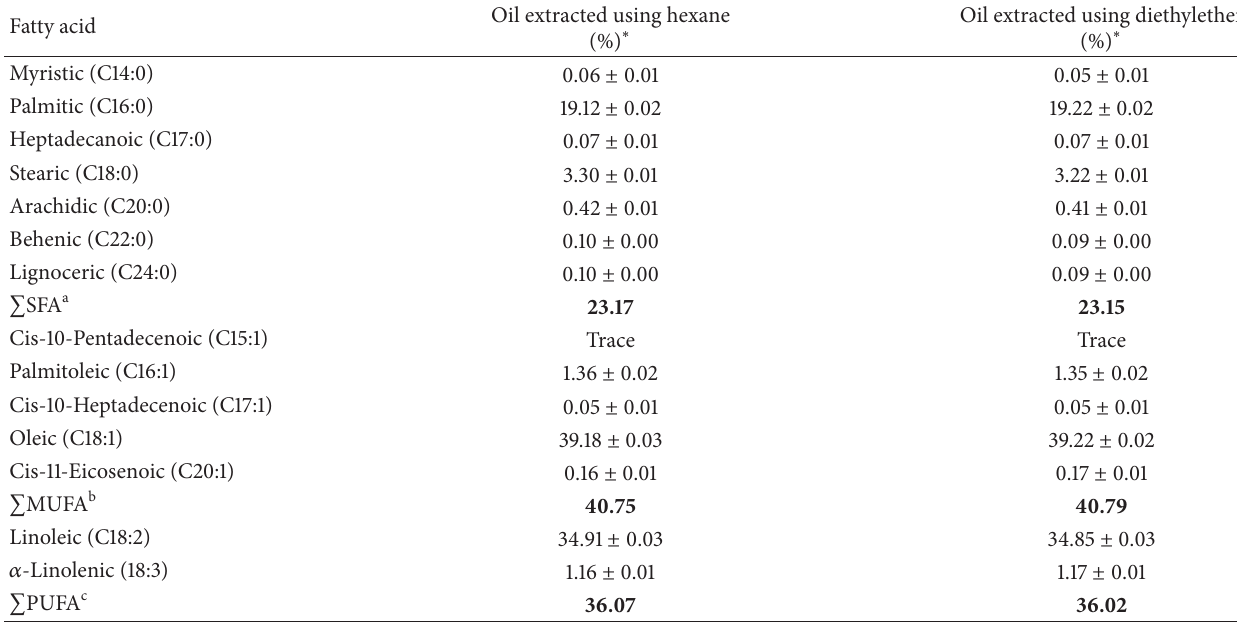
Table 2: Fatty acid composition of fixed oil of Annona muricata L. seeds.